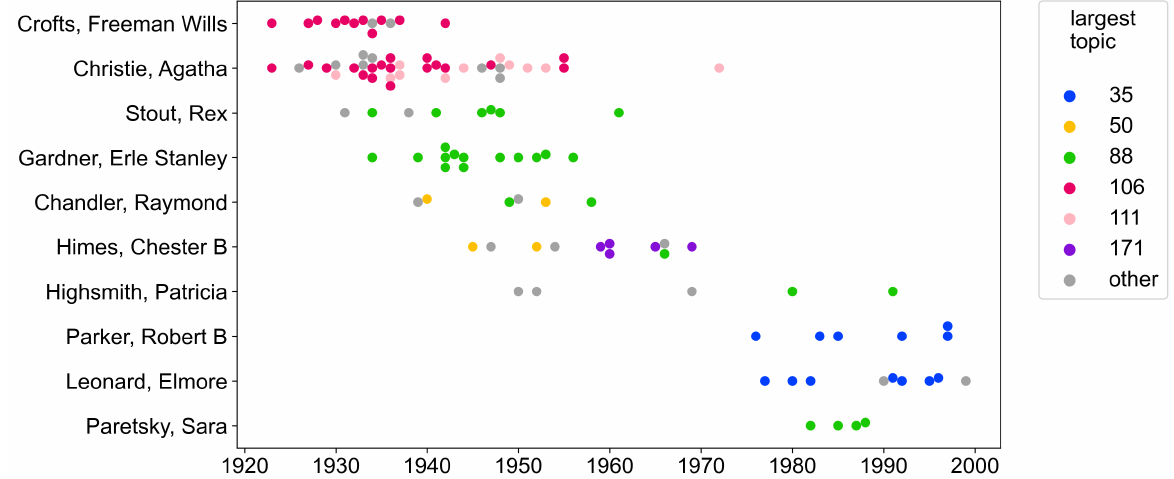
Figure 3: Books by 10 well-known authors of mystery and crime fiction, positioned by publication date and colored by their largest